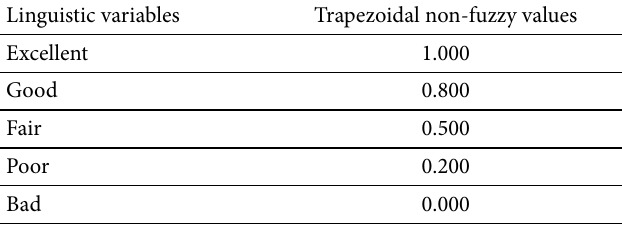
Table 1. Conversion of linguistic variables and into non-fuzzy values to establish the values of the quality criteria